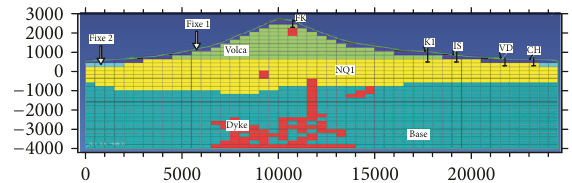
Figure 7: Distributions of modeled temperatures ( ∘ C) (TOUGH2- EOS1) (6A). Horizontal and vertical axes are labeled in meters.